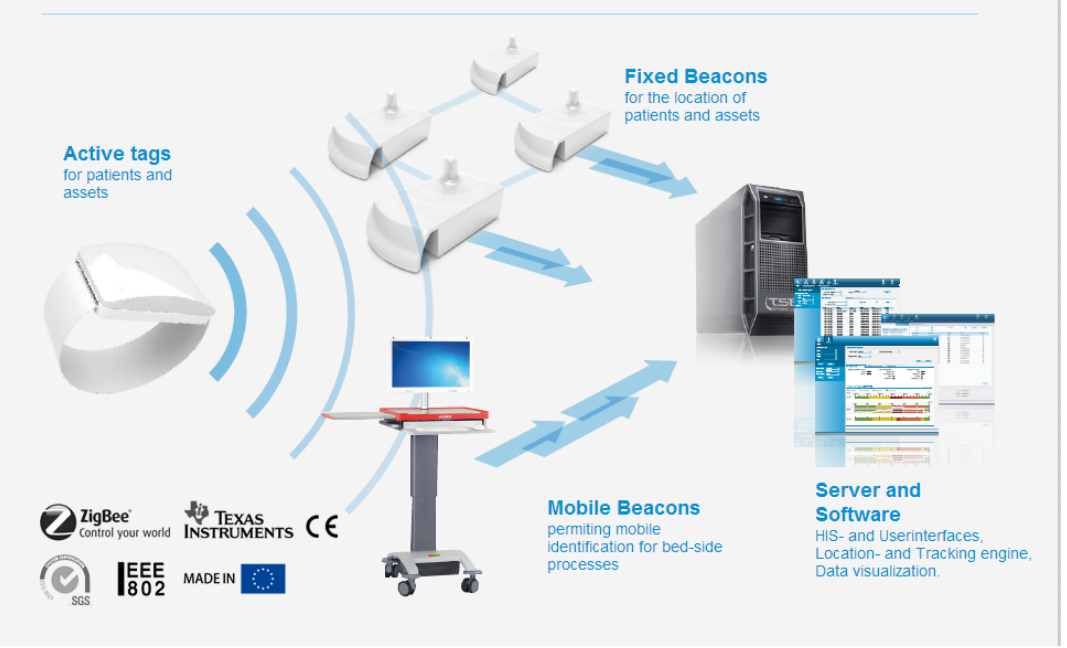
Figure 1. The Sphera System